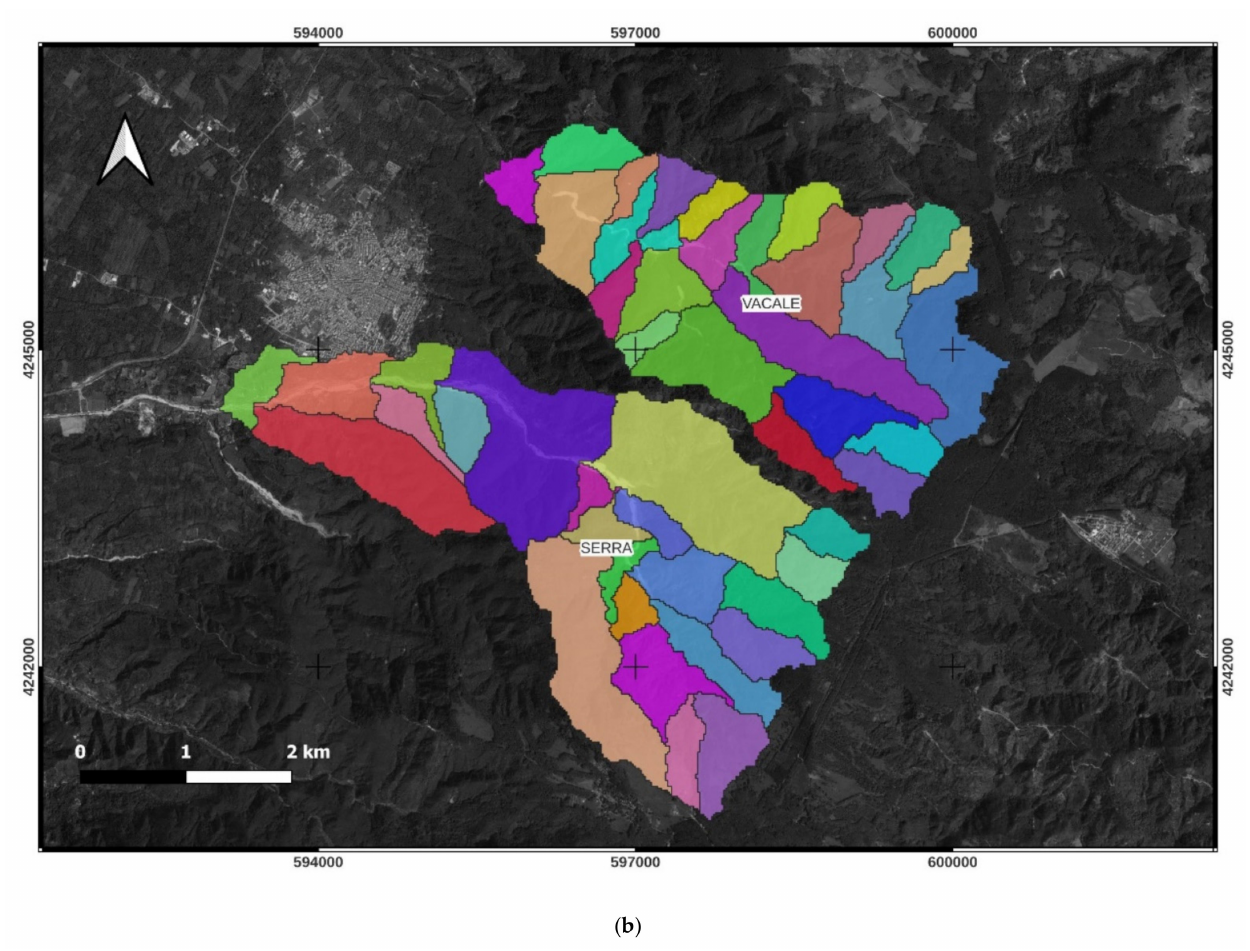
Figure 4. Discretisation of the studied headwaters (( a ) Duverso; ( b ), Vacale and Serra, Calabria, Southern Italy) in hydrological response units using the SWAT